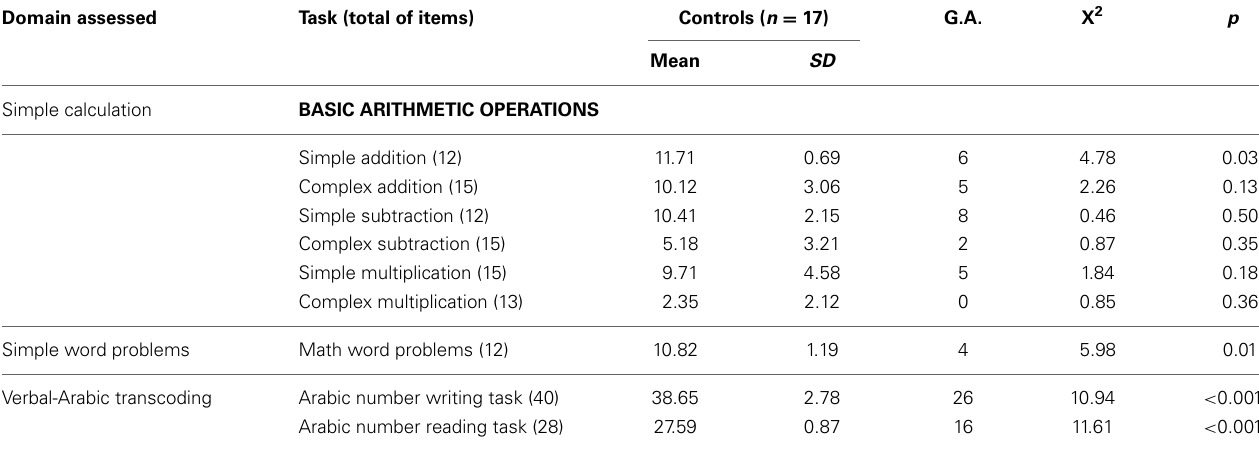
Table 5 | Descriptive data and comparison between control groups and G.A. in the Simple calculation, Simple word problems, and Verbal-Arabic transcoding tasks ( df =